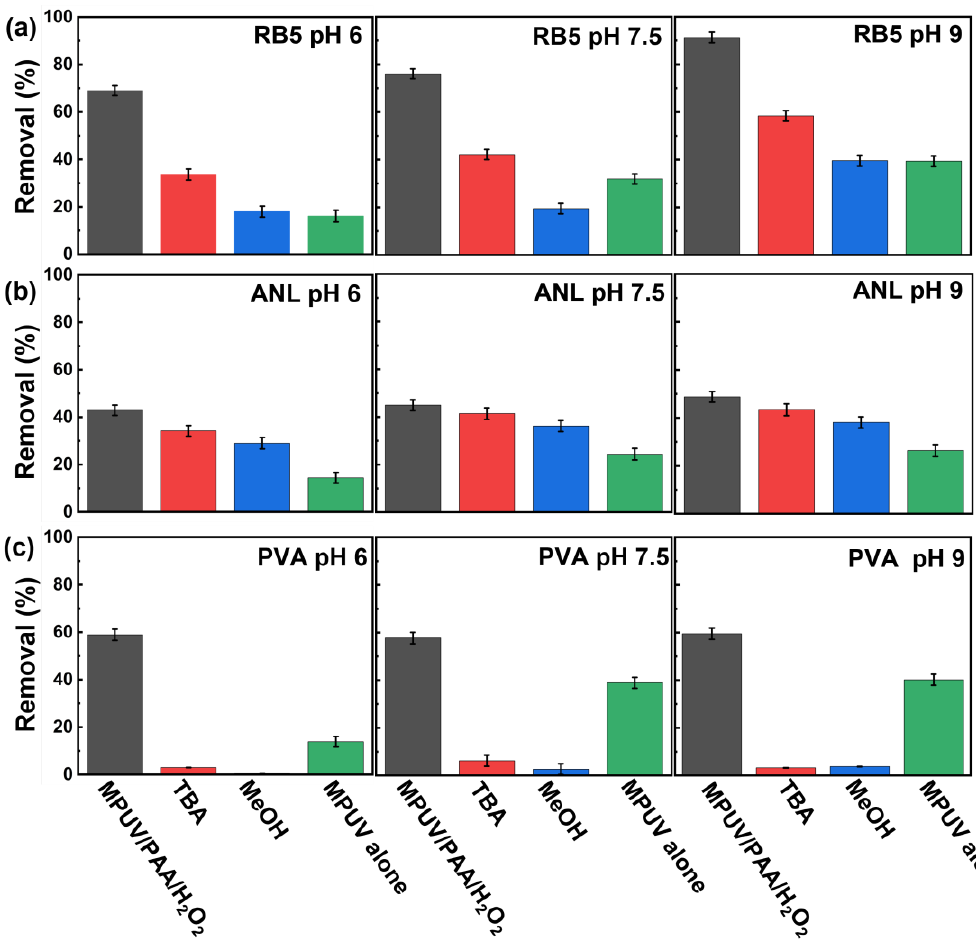
Figure 3. Removal rates of ( a ) RB5, ( b ) ANL, and ( c ) PVA in MPUV/PAA/H 2 O 2 , MPUV/PAA/H 2 O 2 + TBA, MPUV/PAA/H 2 O 2 + MeOH, and MPUV only systems at pH 6, 7.5, and 9, respectively. Conditions: [Contaminant] 0 = 10 mg/L, [PAA] 0 = 15 mg/L, [H 2 O 2 ] 0 = 3 mg/L, UV fluence rate = 5 mW/cm 2 , UV exposure time = 5 min, T = 25 ± 1 °C.